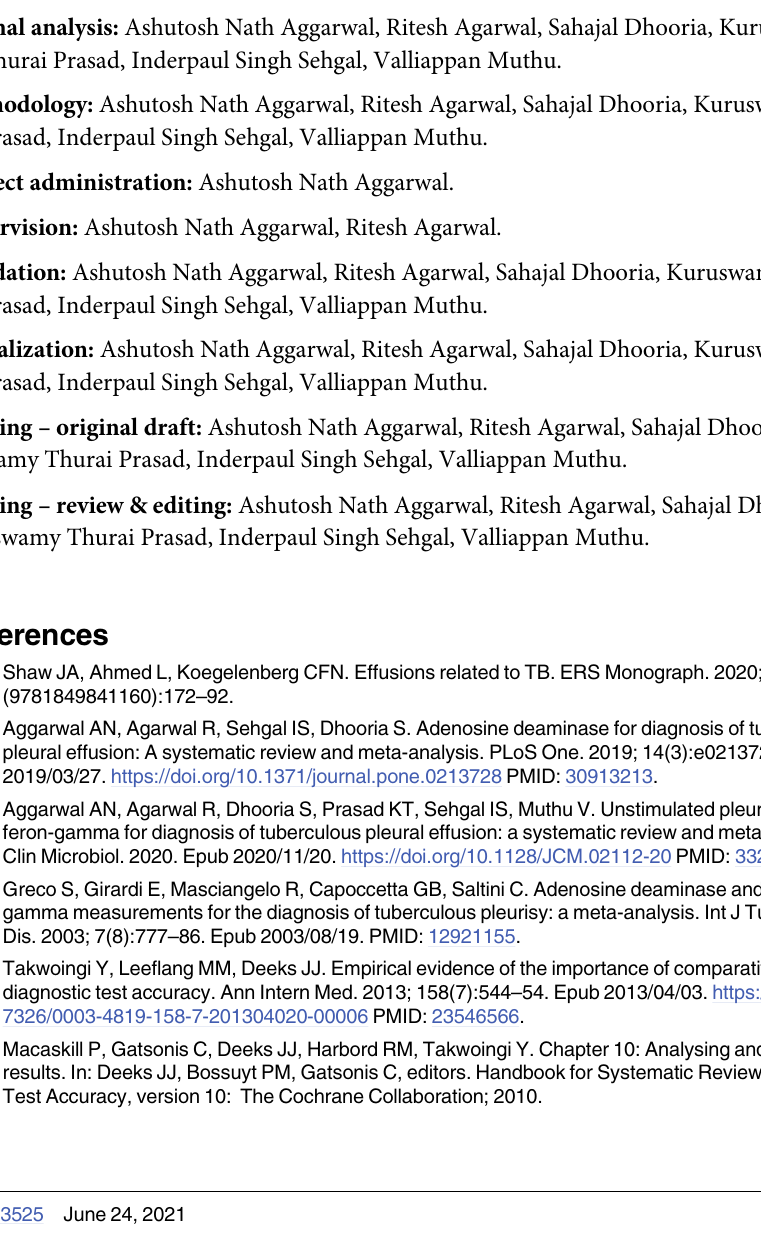
S3 Fig. Coupled forest plot from studies on diagnostic accuracy of pleural fluid adenosine deaminase and interferon-gamma in the same patient population. (PDF) S4 Fig. Likelihood ratio matrix. (PDF) S5 Fig. Summary plots from hierarchical summary receiver operating characteristic